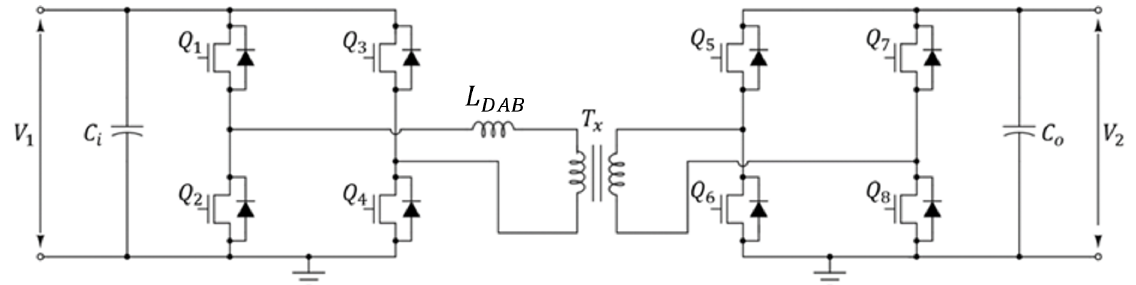
Figure 8. Dual Active Bridge (DAB) circuit with galvanic isolation by the Tx